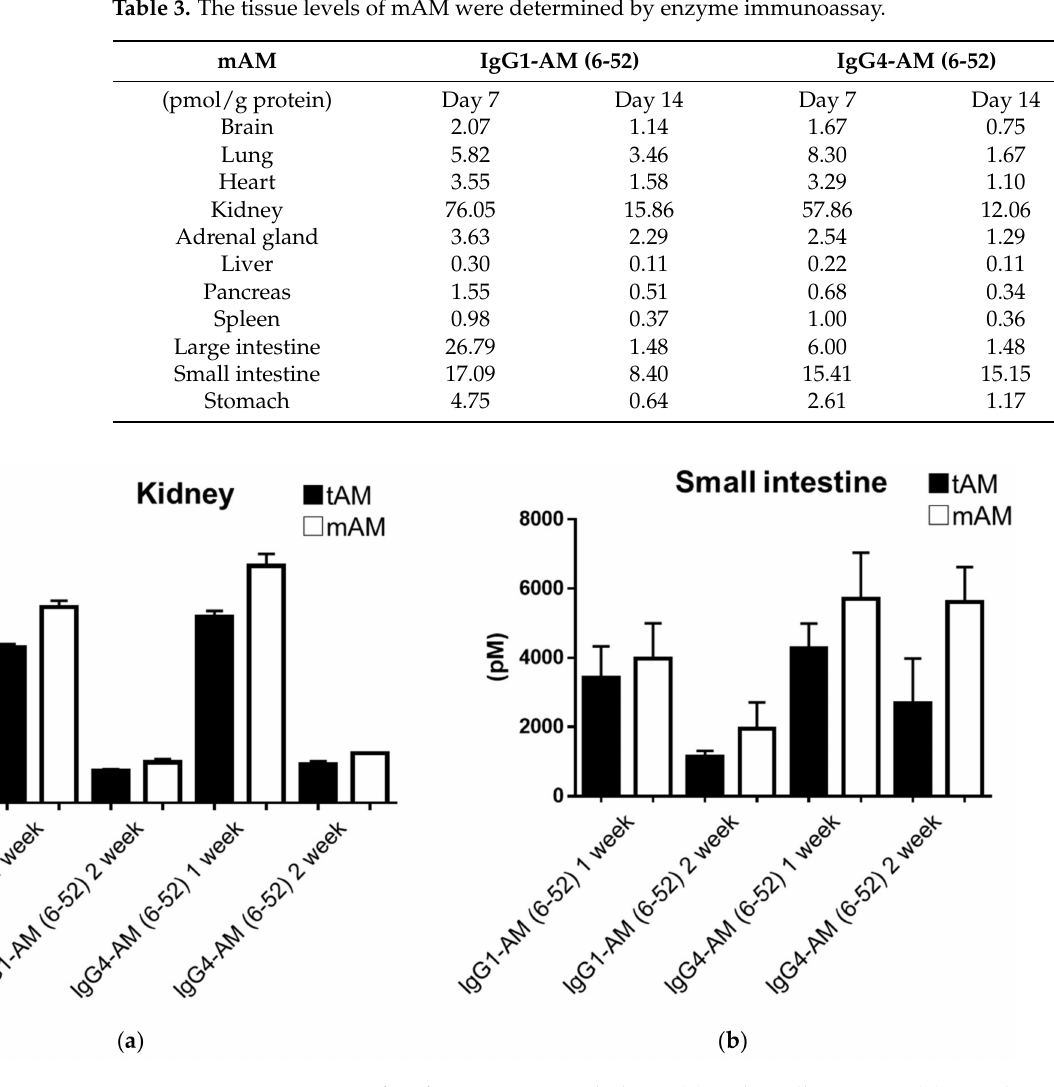
Figure 3. Concentrations of Fc-fusion protein in kidneys ( a ) and small intestines ( b ), 1 and 2 weeks after subcutaneous